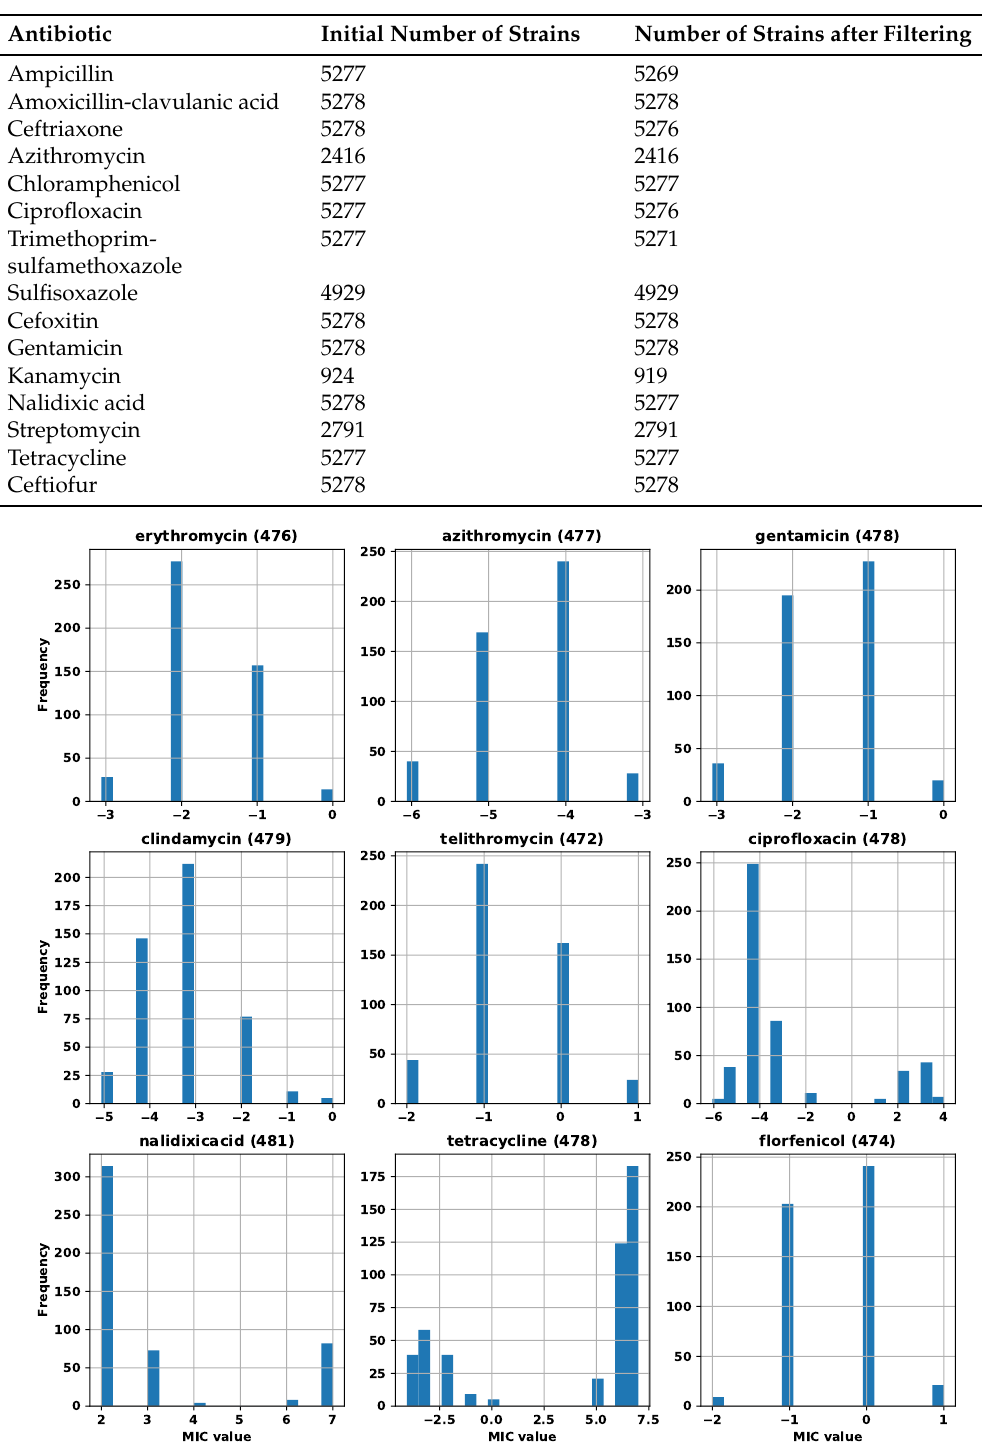
Table A4. S. enterica . Number of genomes for each antibiotic.